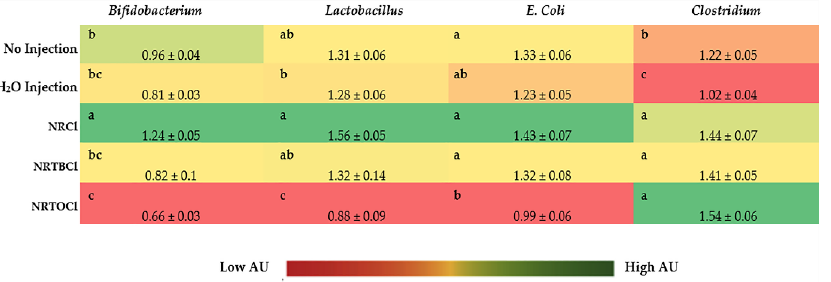
Figure 7. Effects of intra-amniotic administration of experimental solutions on cecal genera and species-level bacterial populations (day of the hatch). Values are means ± SEM, n = 10. a–c Per bacterial category, treatments groups that do not share any letters within the same column are significantly different according to a one-way ANOVA with post hoc Duncan test ( p < 0.05). AU = arbitrary units.